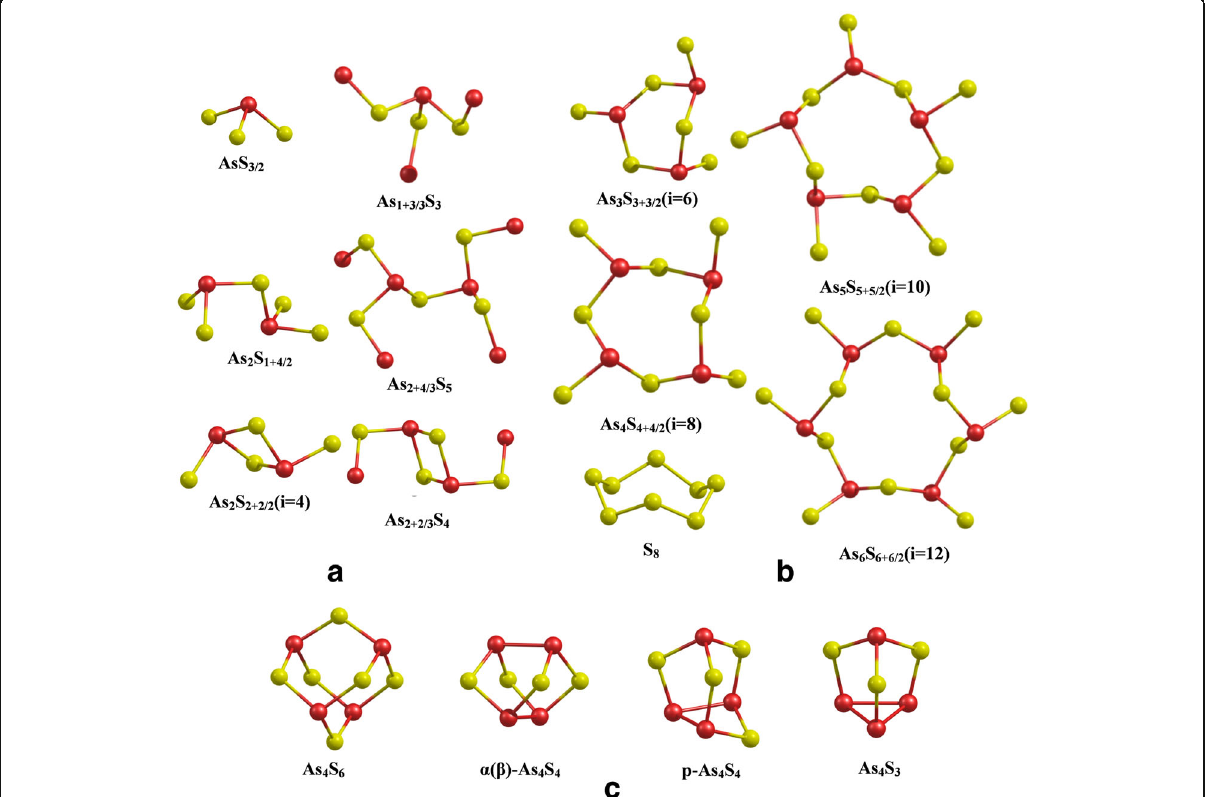
Fig. 3 Branchy- ( a ), ring- ( b ) and cage-like ( c ) As n S m nanocluster models. Saturating hydrogen atoms for branchy- and ring-like nanoclusters are not shown for clarity. ( Color online